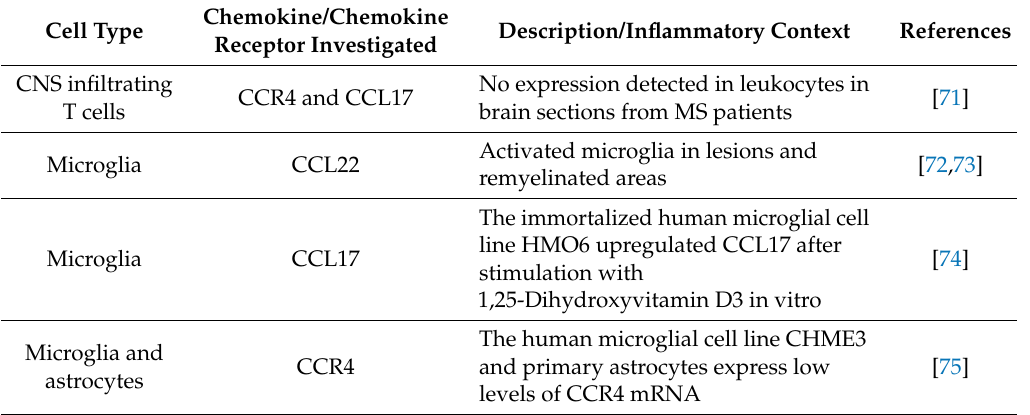
Table 1. Cellular expression of CCR4, CCL17, and CCL22 in the human